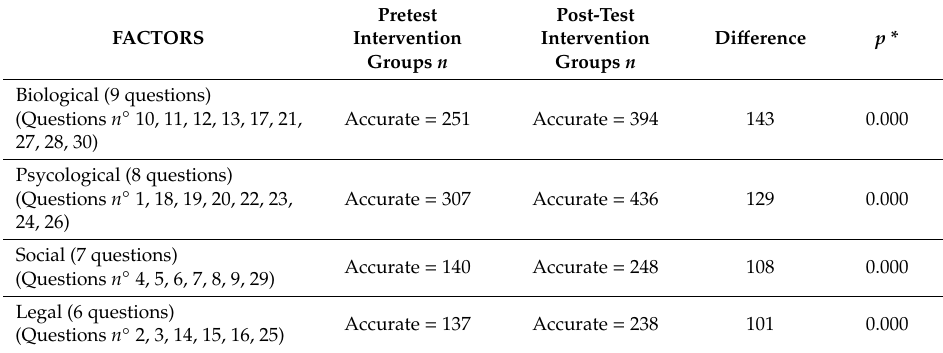
Table 2. Improvement of the accuracy of the KQaT test responses by factors, before and after the intervention ( n =